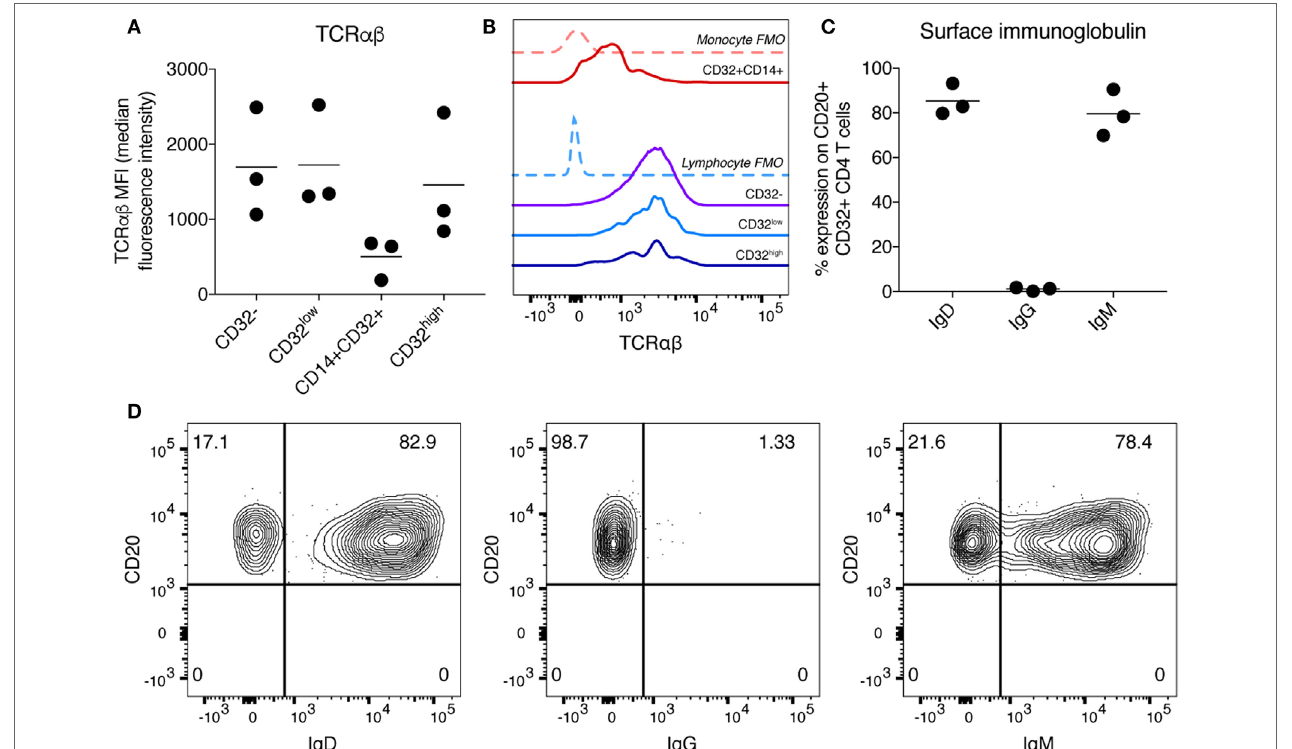
FigUre 2 | Characterization of T cell receptor and immunoglobulin (Ig) expression on CD32 high CD3 + CD4 + T cells. (a) Expression of TCR αβ on CD32-expressing CD3 + CD4 + T cell populations was measured by flow cytometry and is shown here as median fluorescence intensity. Bar is shown at the mean. (B) Histogram showing TCR αβ staining on CD32-expressing CD3 + CD4 + T cell populations of one sample shown in panel (a) . Fluorescence minus one (FMO) controls are shown as dashed lines and individual populations as solid lines. (c) Percentage expression of Ig was measured on CD3 + CD4 + CD32 high CD20 + cells. Expression of IgD, IgG, and IgM is shown. Expression was measured by flow cytometry, and bar is shown at the mean. (D) Representative staining of data shown in panel (c)